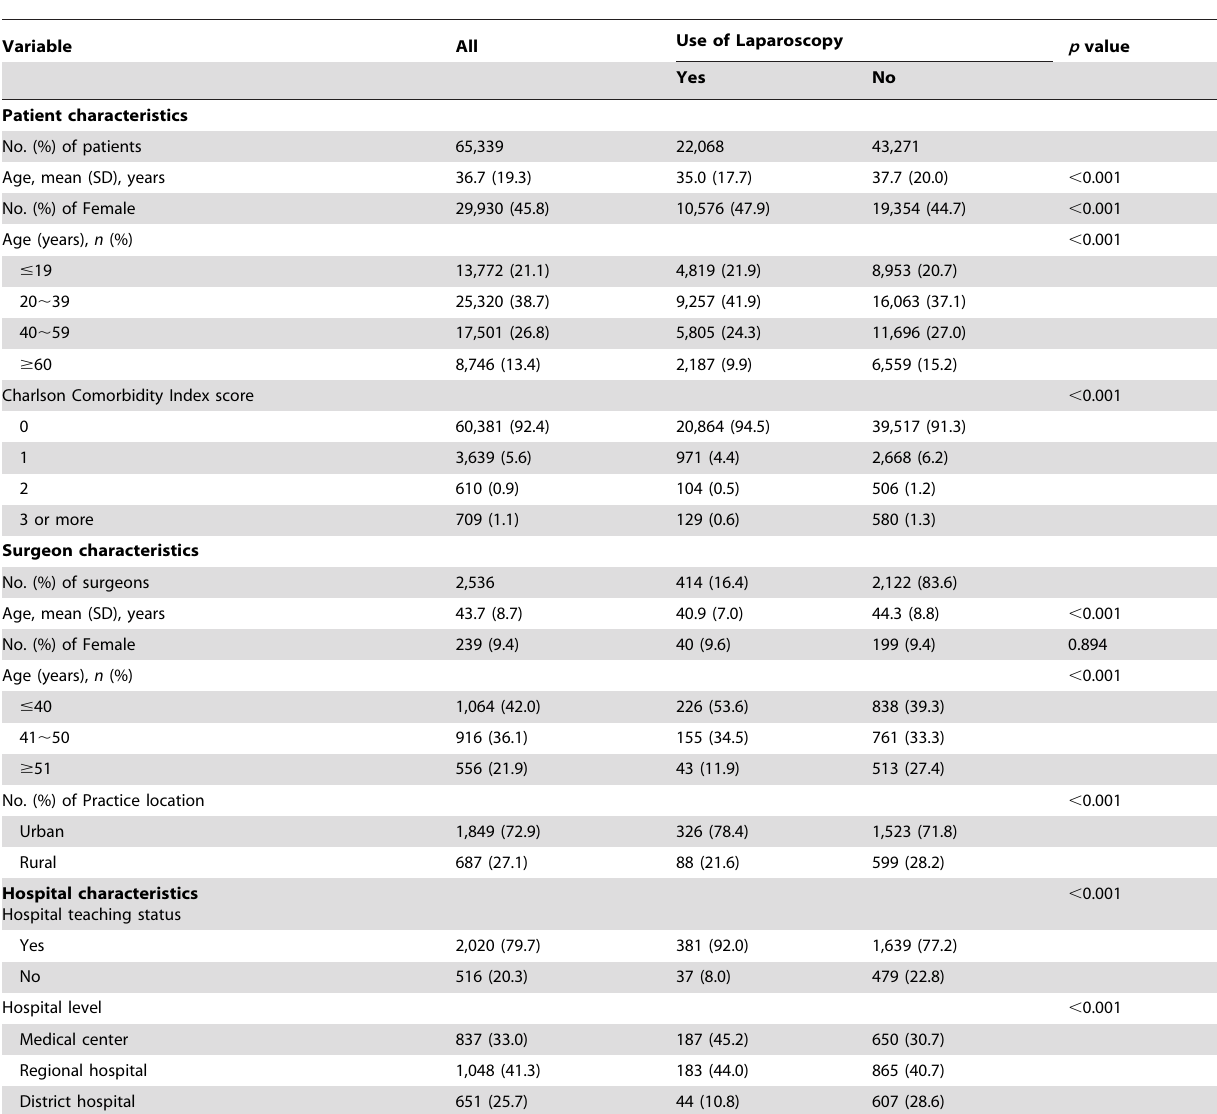
Table 1. Distributions of characteristics of patient, surgeon, and hospital according to the use of laparoscopy (n=65,339).